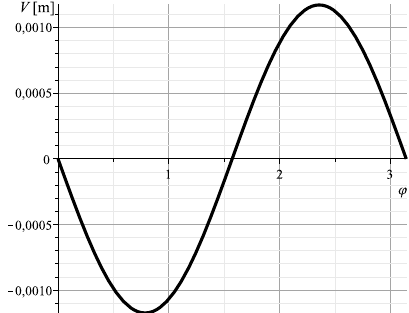
Figure 11: Plot of σ φ as a function of r for φ i ( i = 1 . . . 4) (Example 5.1).